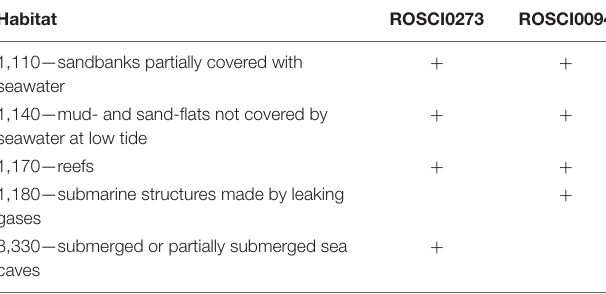
TABLE 1 | Habitats listed in the “Habitats Directive” of the Cape Tuzla and the Mangalia Sulfur springs MPAs (ROSCI0273 and ROSCI0094, respectively), according to the Natura 2000